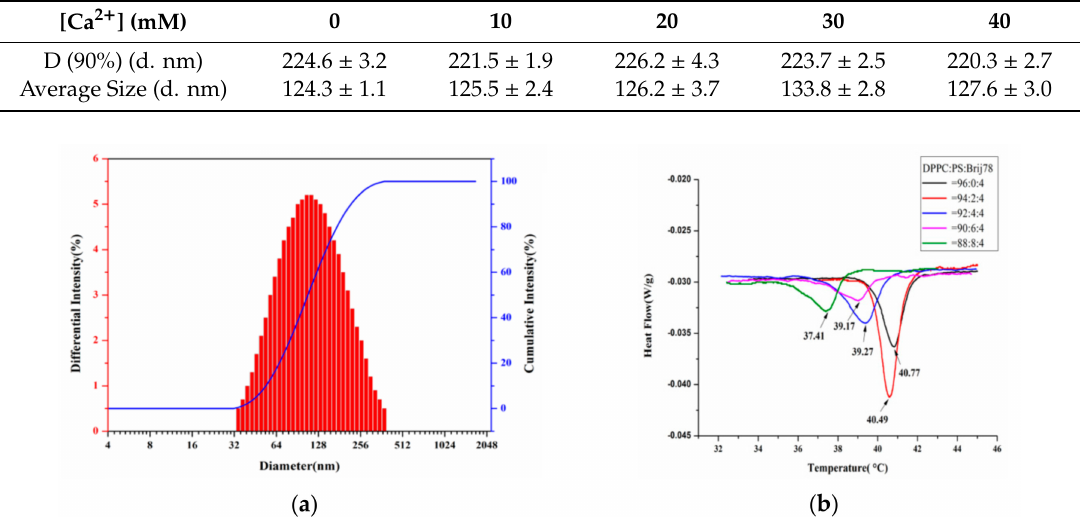
Table 1. Particle sizes of thermosensitive phospholipid microcapsules at di ff erent concentrations of Ca 2 +